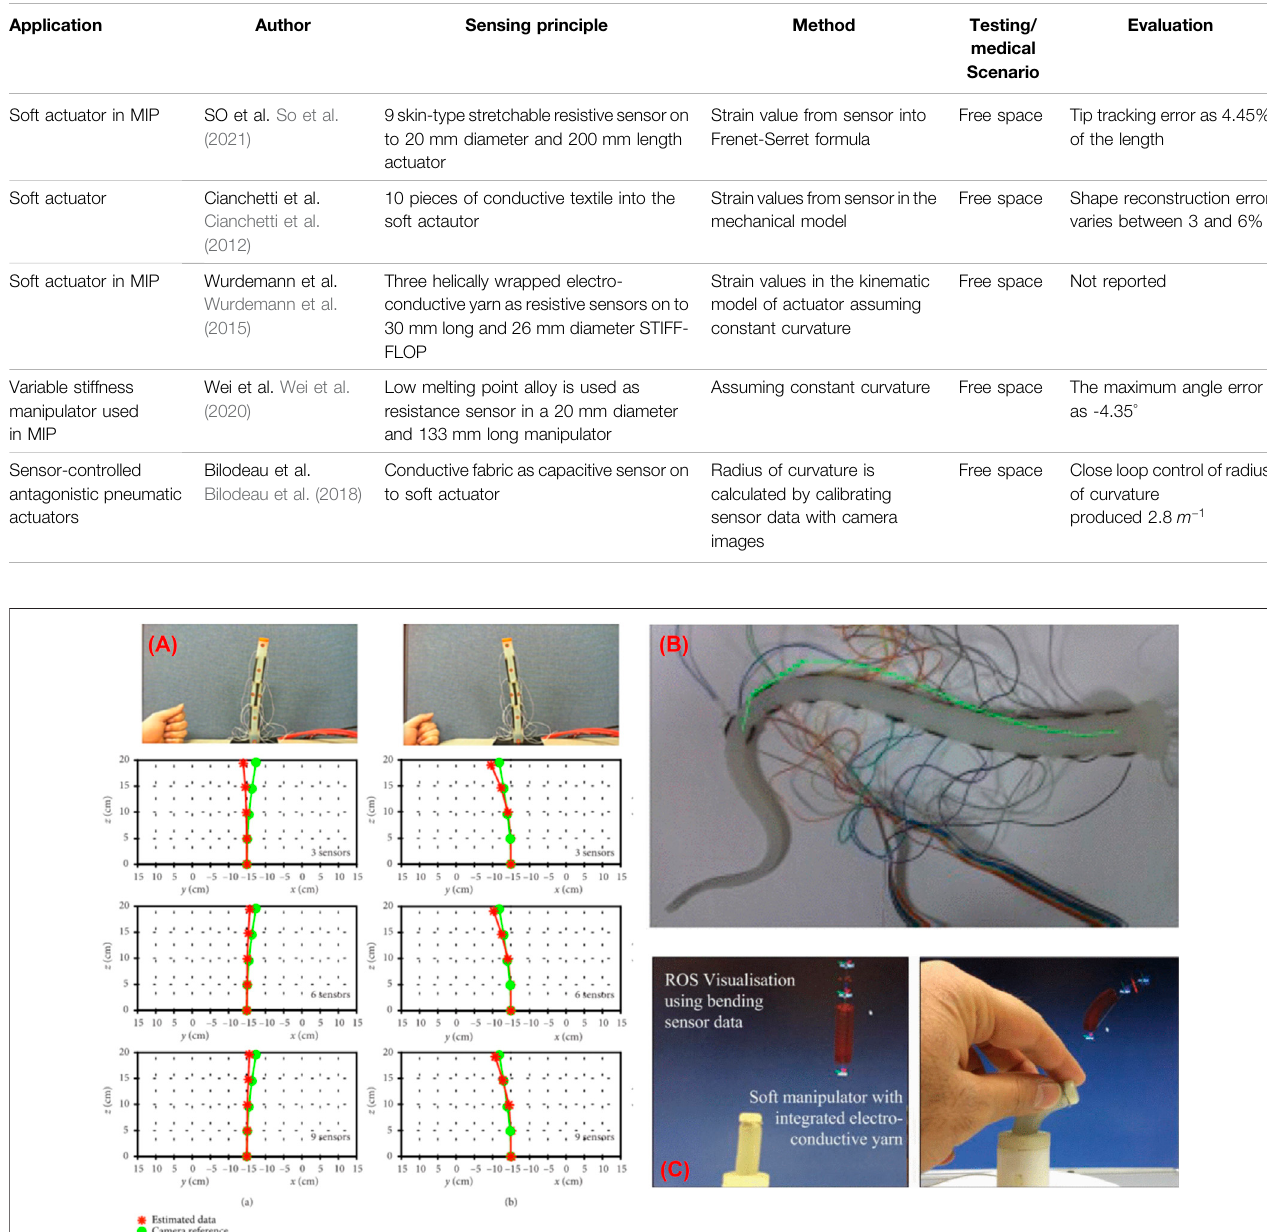
Frontiers in Robotics and AI |